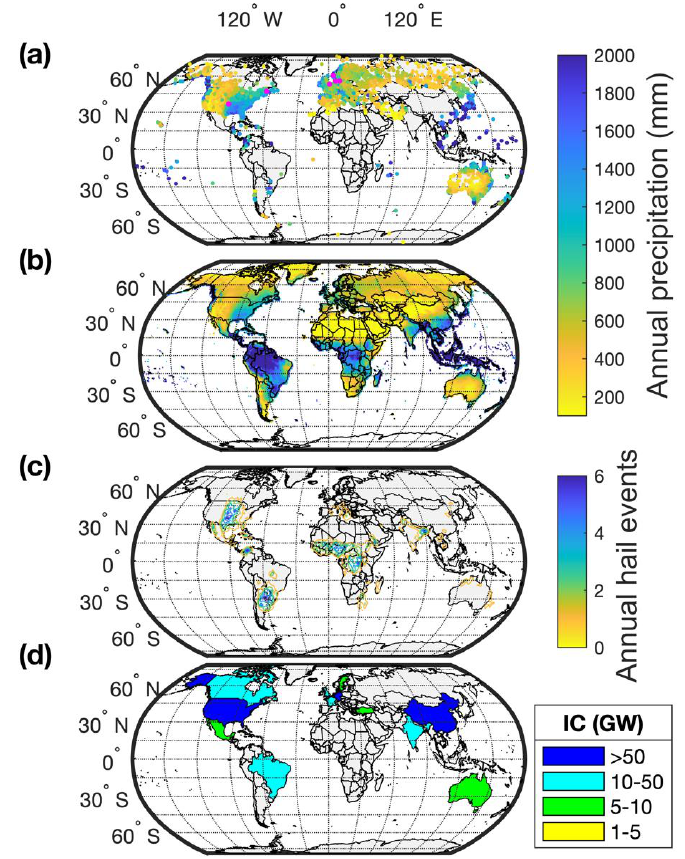
Figure 2. ( a ) Map of mean annual precipitation (mm) computed from the Global Historical Climatology Network (GCHN) dataset (v4) for all 10,468 measurement sites with complete records for the five years; 2015 – 2019. Location (magenta dots) of the primary sites from which hydrometeor and wind data are presented herein. Listed west to east these sites are; Southern Great Plains, United States (US SGP), Canada coastal, UK coastal, Norway coastal, North Sea, and Denmark. ( b ) Map of mean annual precipitation (mm) from the GPCC Full Data Reanalysis Version 7 (data have a spatial resolution of 1 by 1 degree). ( c ) Map of estimated annual hail frequency at 2 deg resolution based on the NASA Passive Microwave Hail Climatology Data Products V1 data set and observations from 2014 – 2022 [75]. ( d ) Map showing countries that have either more than 5 GigaWatts (GW) of wind energy installed capacity (IC) onshore or more than 1.5 GW offshore (as of end of 2020) based on data from the GWEC 2020 status report